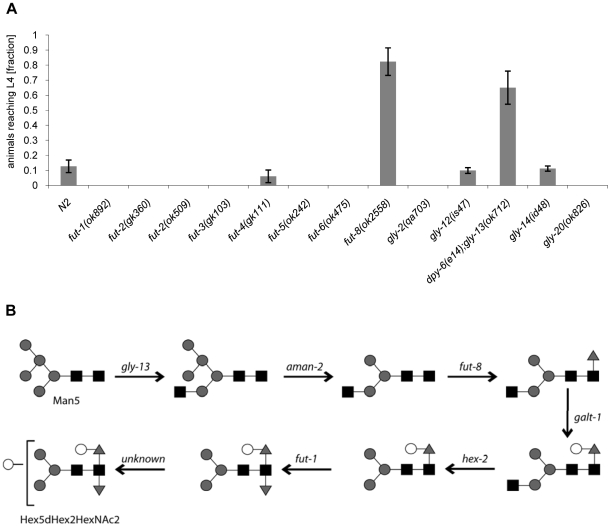
CGL2-sensitivity test and biosynthetic context of available C. elegans fucosyltransferase and GlcNAc-transferase mutants.(A) CGL2-sensitivity test. C. elegans mutants of the indicated genotypes were analysed for development from L1 to L4 as outlined above. The differences between the L4 fractions of the fut-4(gk111) and dpy-6(e14);gly-13(ok712) mutants to N2 are statistically significant (p<0.01) in contrast to the differences between the L4 fractions of the fut8(ok2558), gly-12(is47) and gly-14(id48) mutants to N2 (p<0.9). The differences of the residual mutants to N2 could not be evaluated due to the lack of variance. (B) Biosynthetic context. The putative pathway for biosynthesis of the CGL2 epitope, based on previous in vivo and in vitro data, indicates the key roles of the enzymes encoded by the gly-13, fut-8 and galt-1(M03F8.4) genes; on the other hand, FUT-1 acts after the processing by hexosaminidases such as HEX-2. Other fucosyltransferases such as FUT-2 through to FUT-6 are not involved in modification of the reducing-terminal GlcNAc residue of N-glycans, whereas the gly-2 and gly-20 encoded enzymes are not prerequisites for α1,6-fucosylation by FUT-8. Further modifications by other enzymes, encoded by unknown genes, are possible and result in structures such as the depicted Hex5dHex2HexNAc2 glycan.